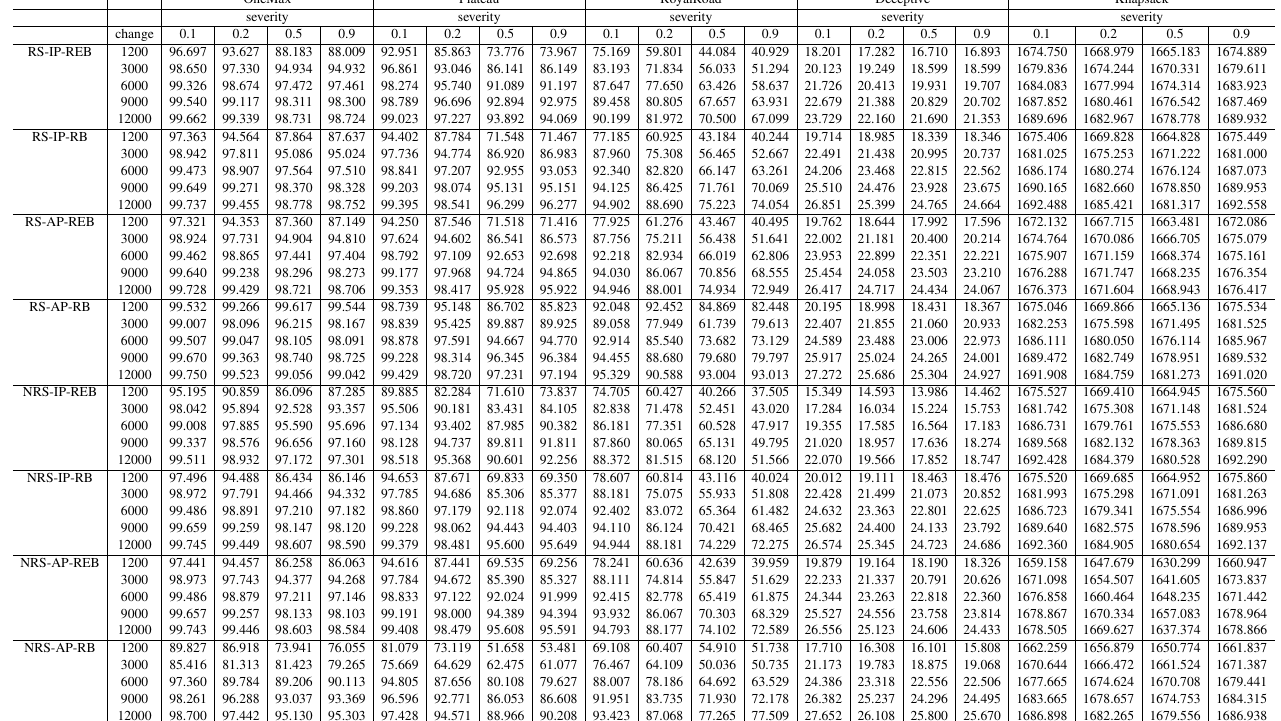
Table A.1. Offline performance obtained in 30 runs by each learning schemes considered in the experimentation for each problem, severity and frequency of change. OneMax Plateau RoyalRoad Deceptive Knapsack severity severity severity severity severity change 0.1 0.2 0.5 0.9 0.1 0.2 0.5 0.9 0.1 0.2 0.5 0.9 0.1 0.2 0.5 0.9 0.1 0.2 0.5 0.9